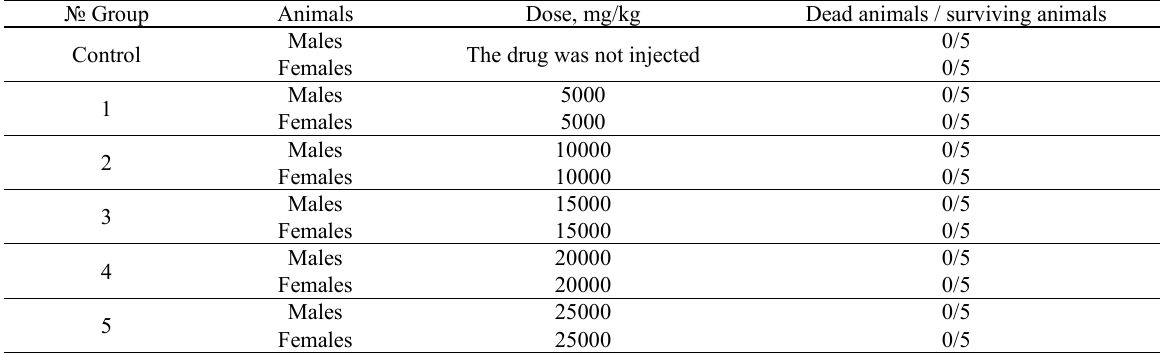
Study of acute toxicity (LD 50 ) of the drug under conditions of single intragastric administration for rats № Group Animals